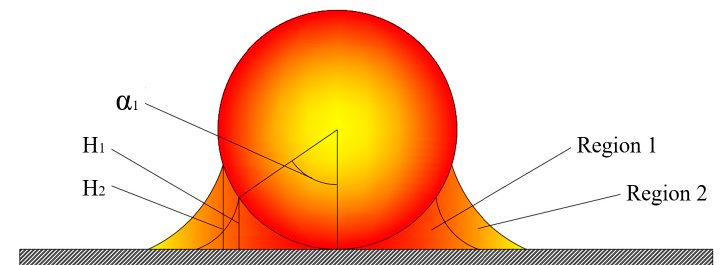
Figure A1. Schematic diagram of the cross section.